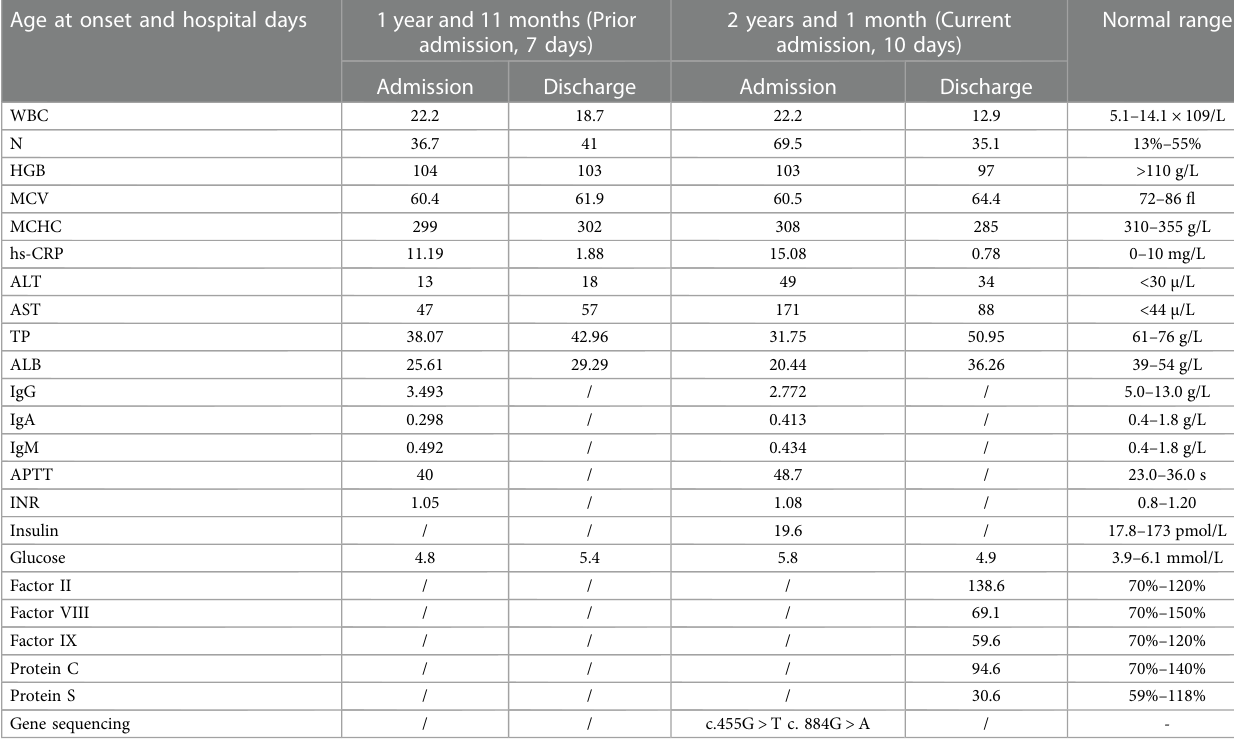
TABLE 1 The main laboratory fi ndings during two hospitalizations in our hospital. Age at onset and hospital